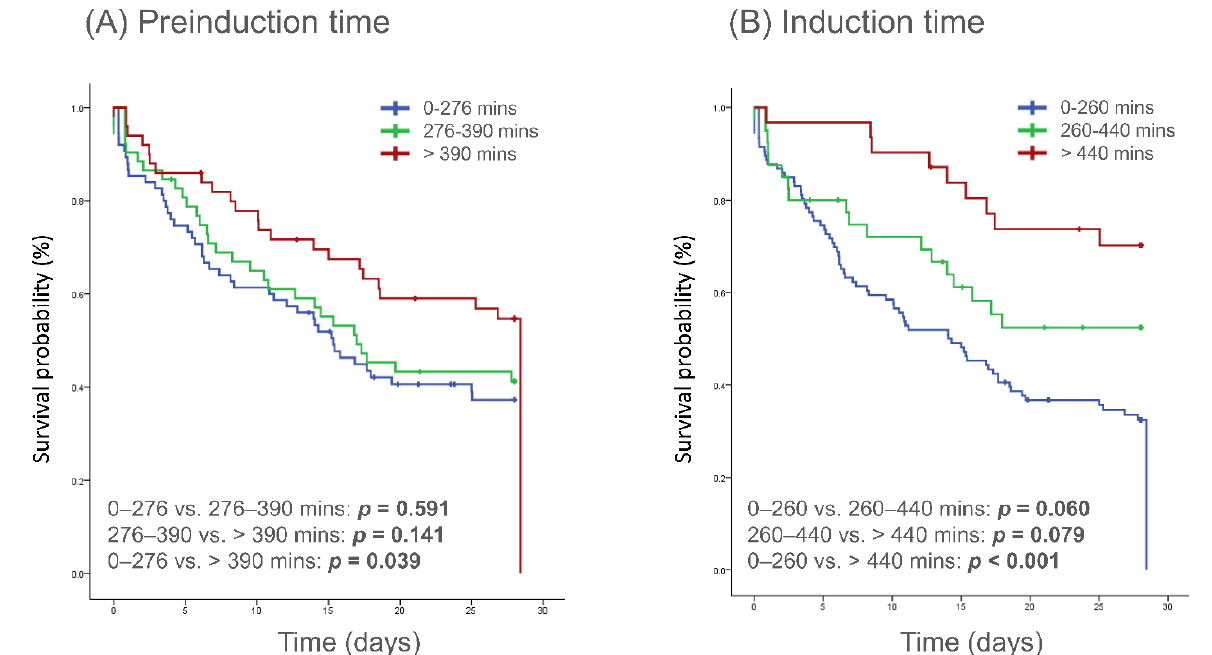
Figure 3. Kaplan–Meier curves of the cumulative probability of survival to day 28 after cardiac arrest according to different pre-induction ( A ) and induction time ( B ). Table 5. Univariant and multivariant Cox model results for mortality at 28 days.